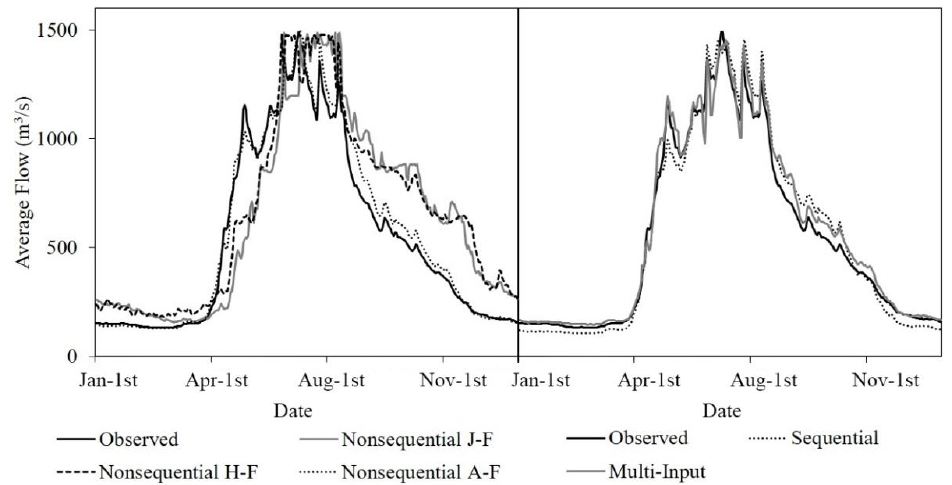
Figure 6. Hydrographs showing the results for the ANFIS models for Approach 1.